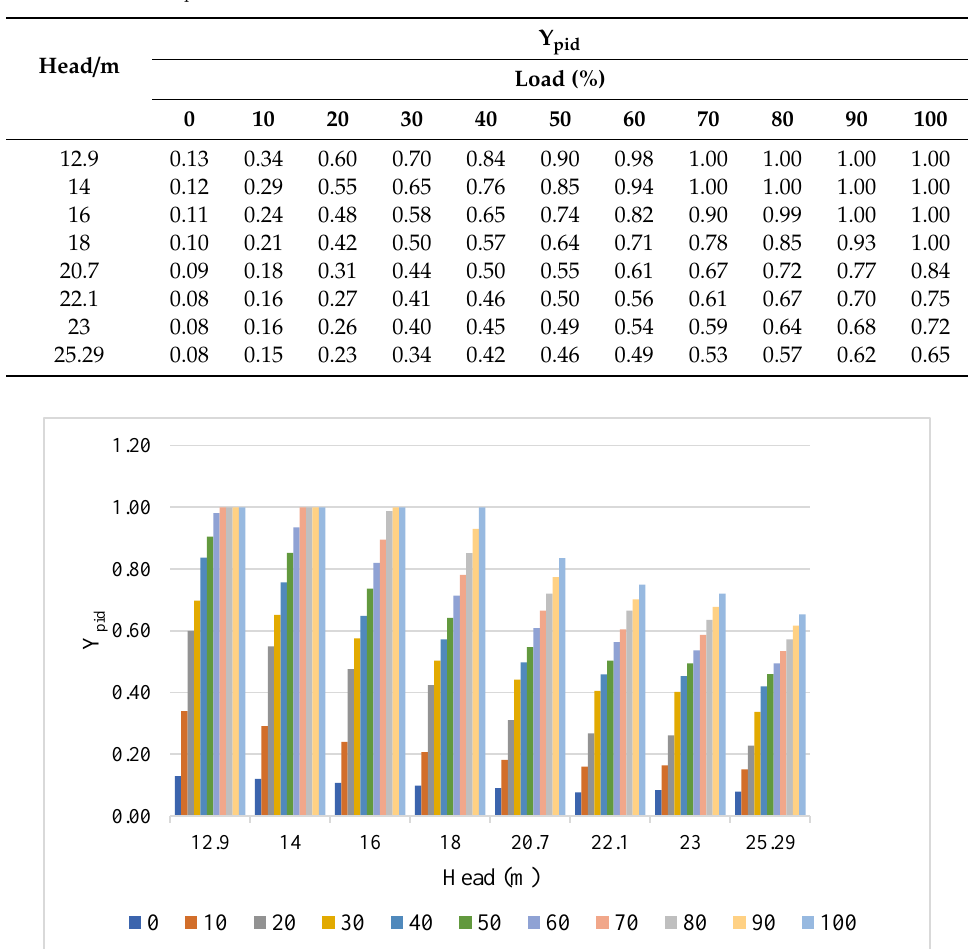
Figure A1. Y pid fitting of feed-forward control. The 11 values under each head represent the load from 0% to 100%. Table A2. Basic parameters of experimental HHP.